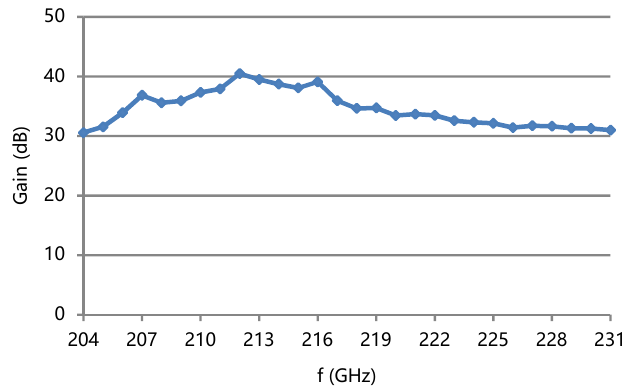
Figure 18. Measured saturation output power of the TWT.